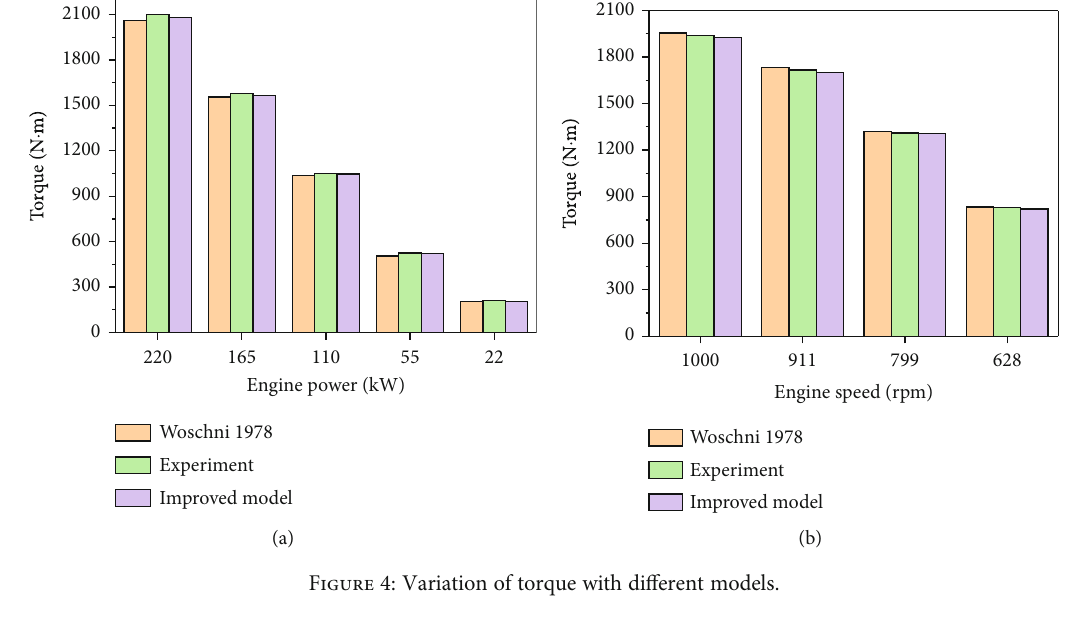
Figure 4: Variation of torque with di ff erent models.